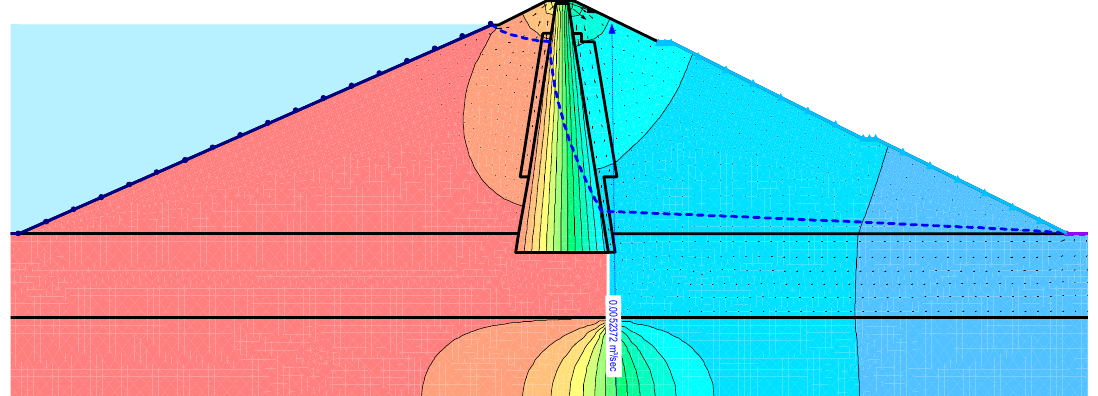
Figure 6. Water flow lines of the dam with vertical curtain on upstream.